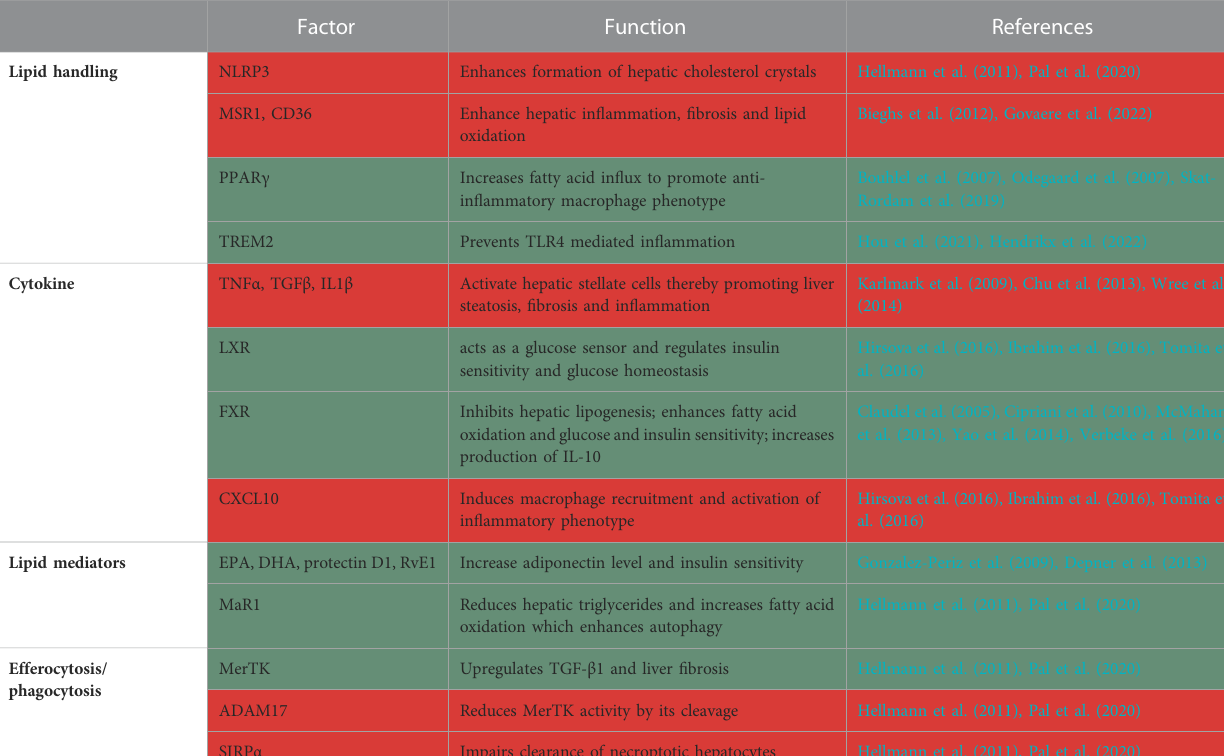
TABLE 3 Summary of factors in macrophages that protect from (green) or promote (red)